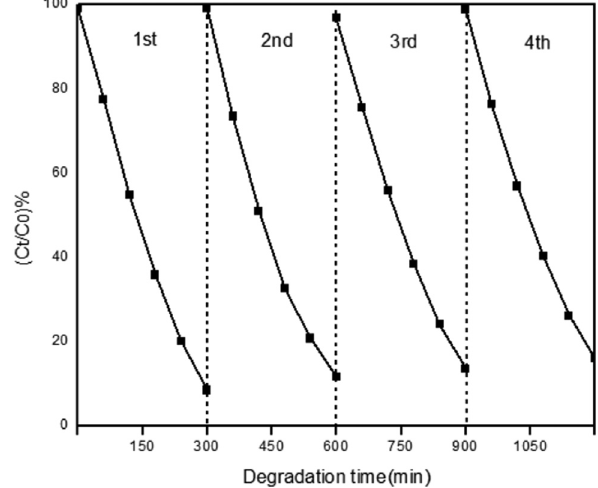
Figure 5: Stability of GCBC - 0.1% degradation